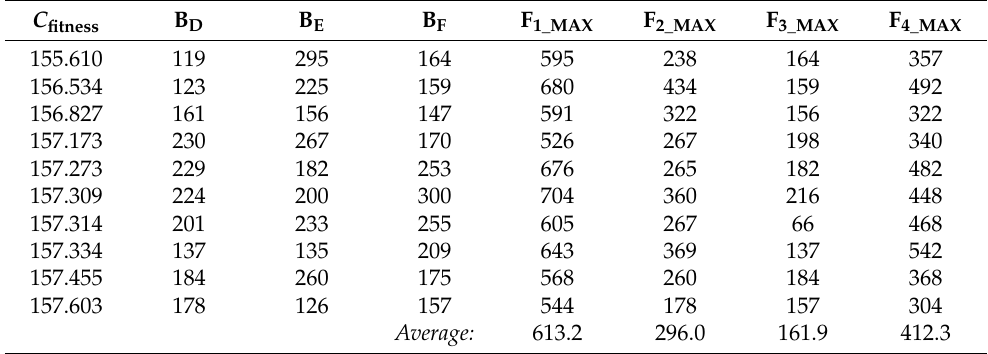
Table 6. Required buffer configuration.